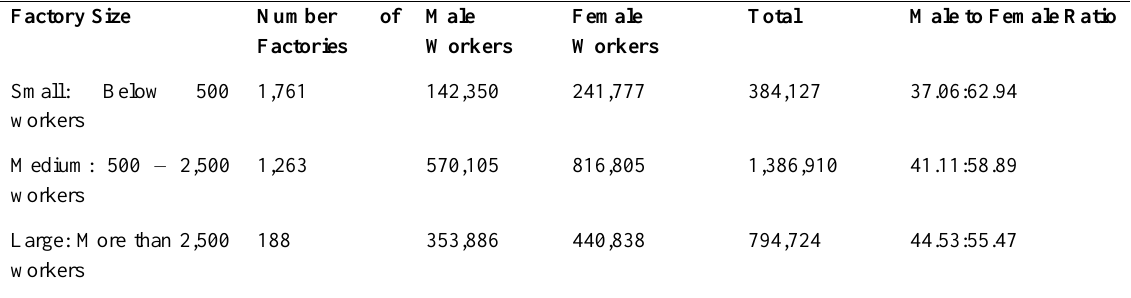
Table 6: Gender Ratio by Factory Size (Based on Category of